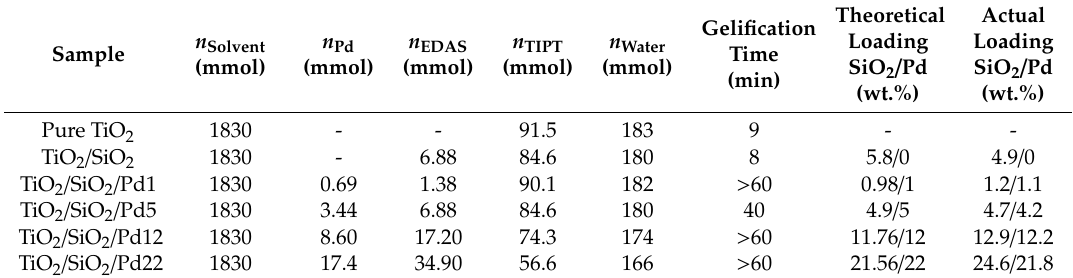
Table 1. Synthesis operating variables and additive loadings determined by